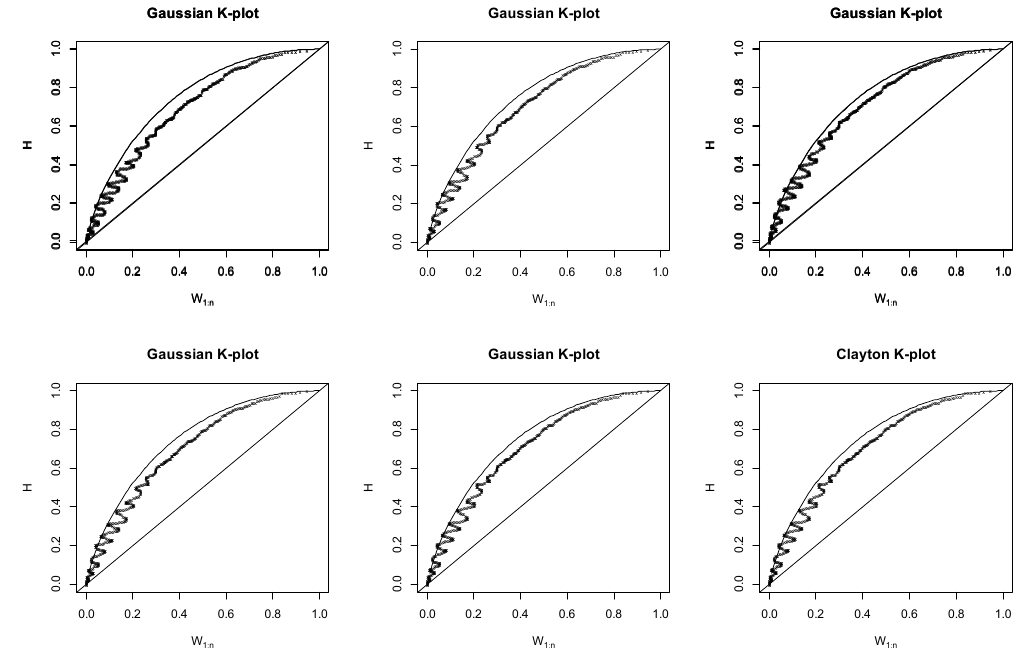
Figure 9. K-plots of pair flood volume variables of Zhangjiashan and Xianyang.